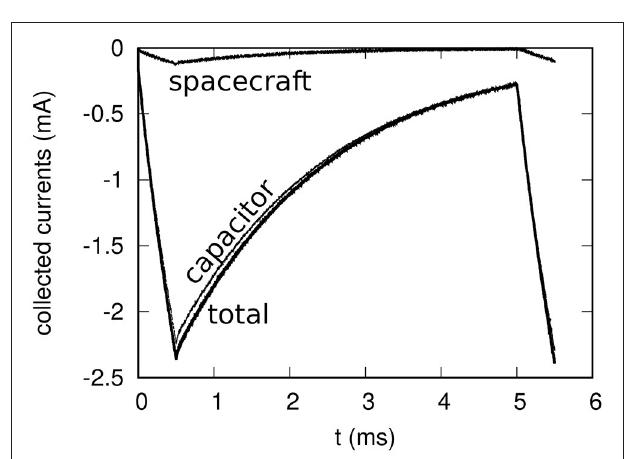
FIGURE 3 | Collected current by the spacecraft, the capacitor and the sum of the two, over a 5.5 ms time